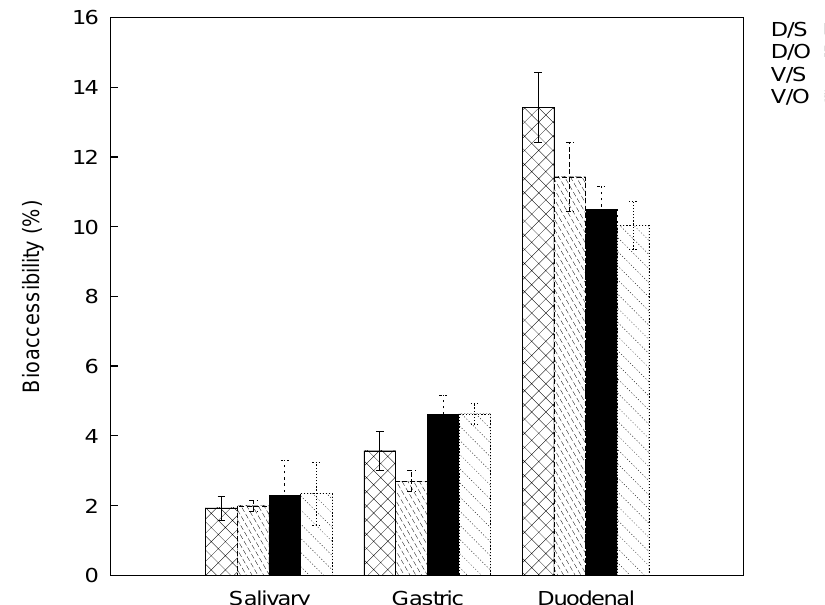
Figure 3. Bioaccessibility of lutein from cooked pumpkins: D/S, “Delica” steam-cooked; D/O, “Delica” oven-cooked; V/S, “Violina” steam-cooked; V/O, “Violina” oven-cooked.